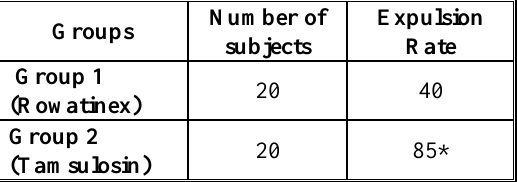
Table 1: The effects of rowatinex and tamsulosin on the expulsion rate of ureteric stone